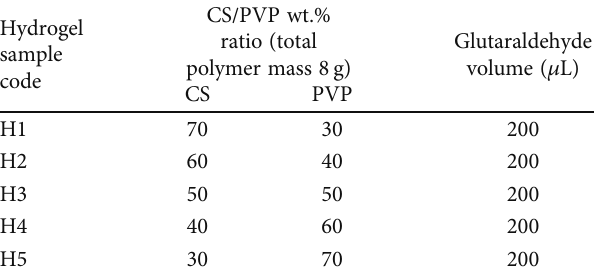
Table 1: Composition of CS/PVP